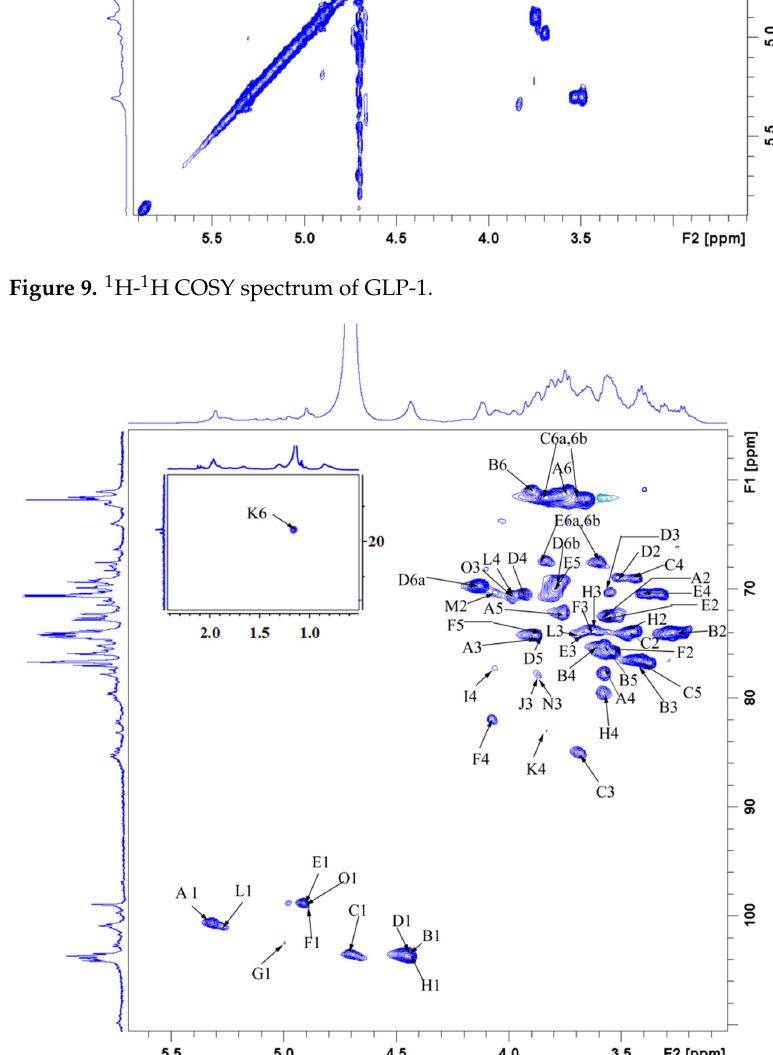
Figure 10. HSQC spectrum of GLP-1.